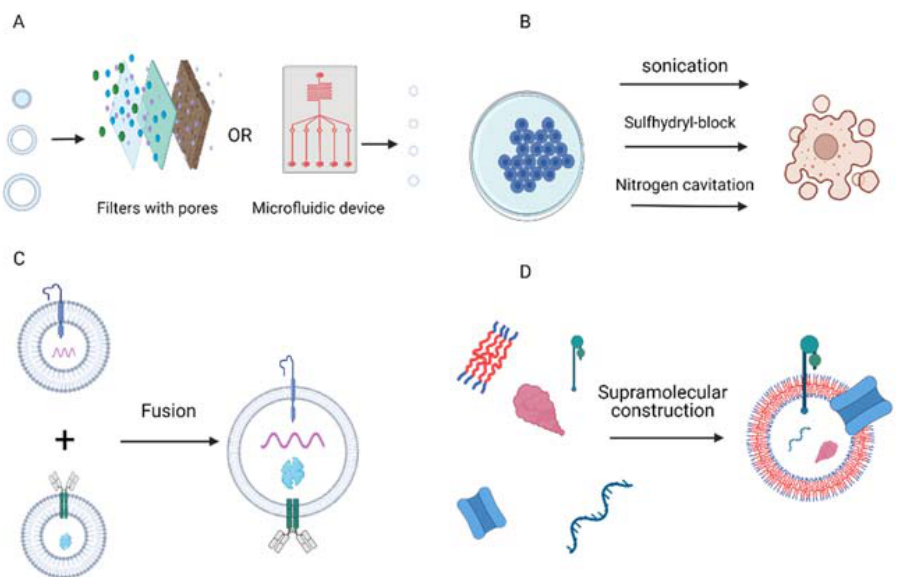
Figure 1. The construction of artificial exosomes ( A , B ), the “top-down” strategy: forced passage through porous membranes or microfluidic devices, nitrogen cavitation; cell membrane blebbing. ( C ) The supramolecular construction of artificial exosomes with biohybrid technologies ( D ), the “bottom-up” methodology: the supramolecular construction of complex structures from basic compo- nents. Created with BioRender.com.